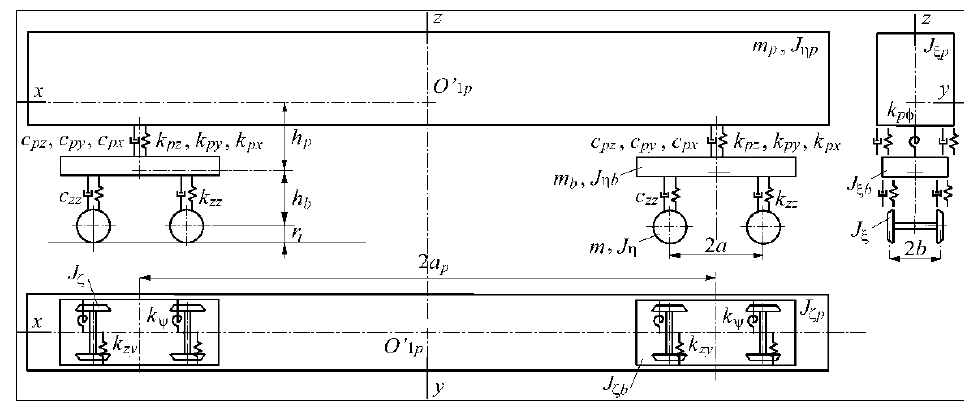
Figure 2. 4-axle vehicle model.